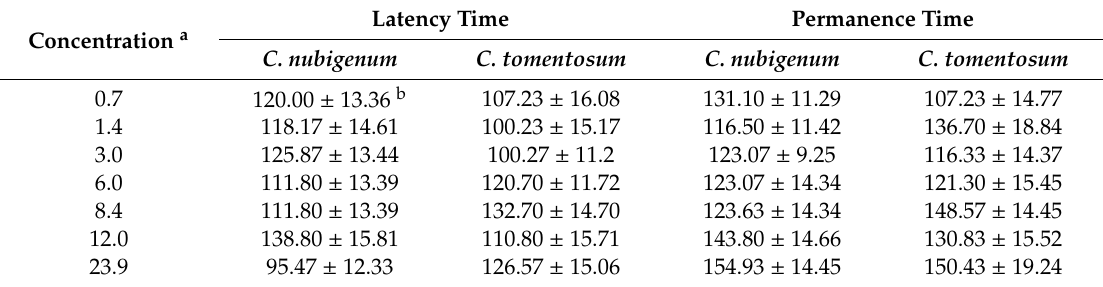
Table 3. Sitophilus zeamais latency time and permanence time on the olfactory stimulus ( Clinopodium nubigenum and C. tomentosum EOs) in the two-choice